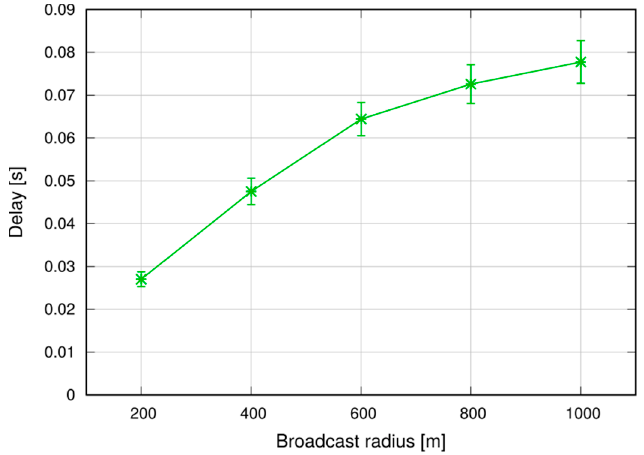
Figure 27. Average broadcasting delay.